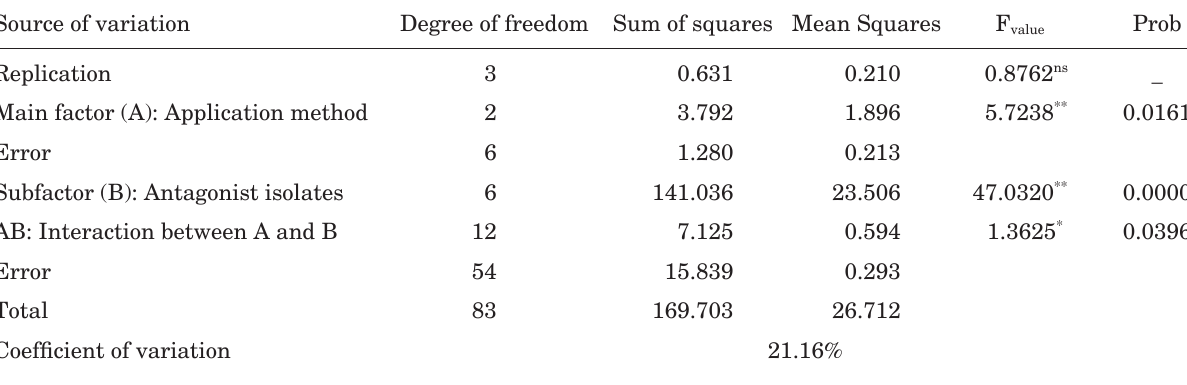
Table 4. Analysis of variance for data of the greenhouse